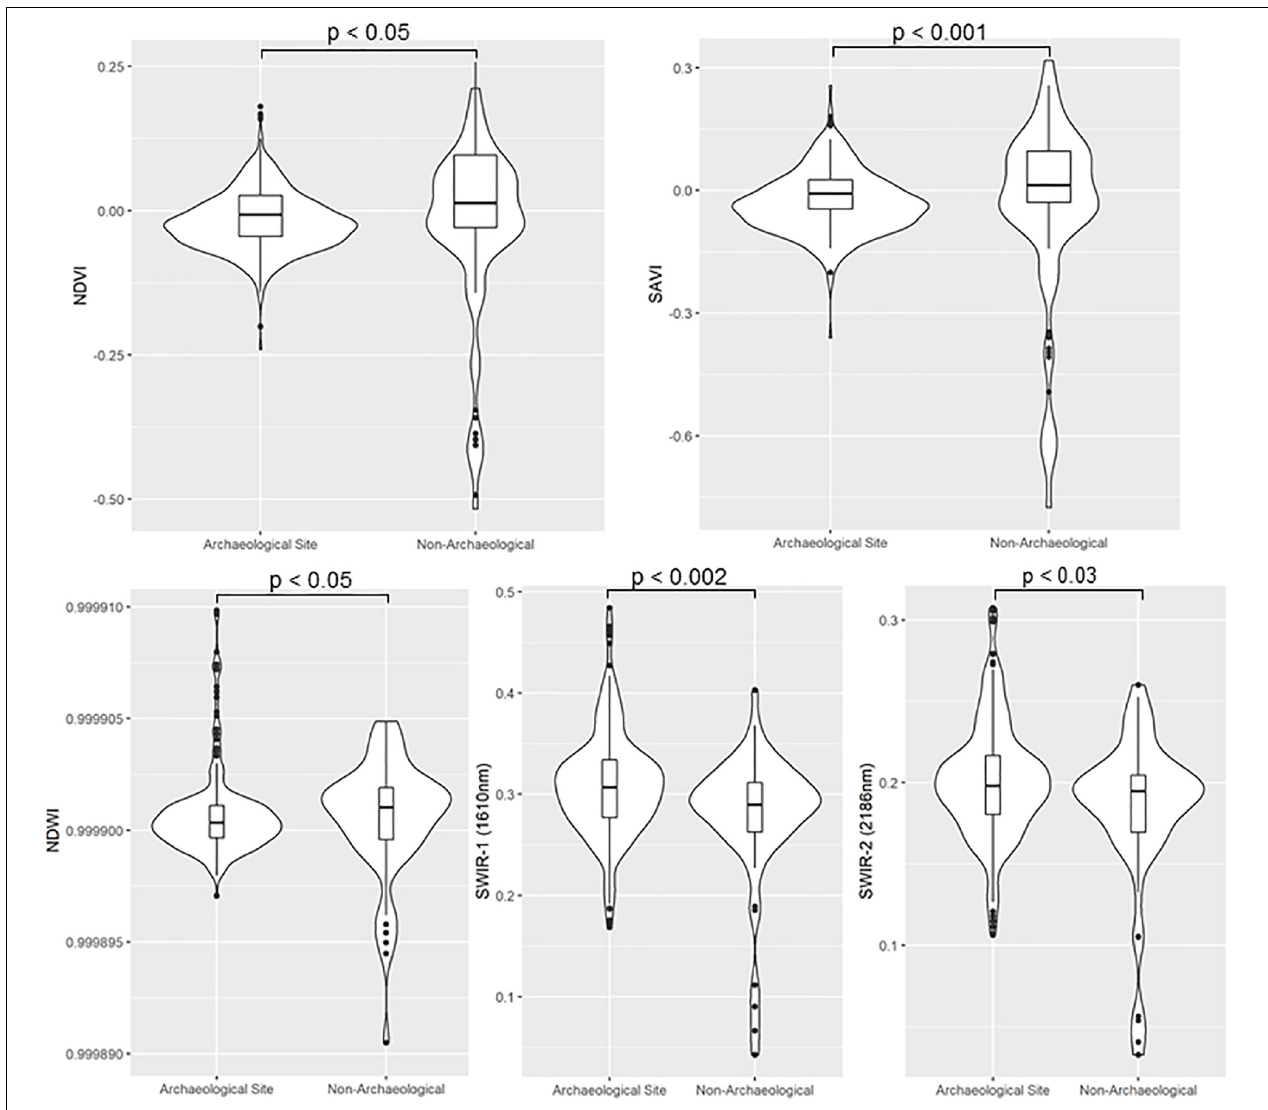
FIGURE 5 | Vegetation index values for archaeological and non-archaeological locations. NDVI and SAVI are annual averages over 3 years of PlanetScope imagery (Planet Team, 2020). Normalized Difference Water Index (NDWI) uses the annually averaged PlanetScope and Sentinel-2 short-wave infrared (SWIR)